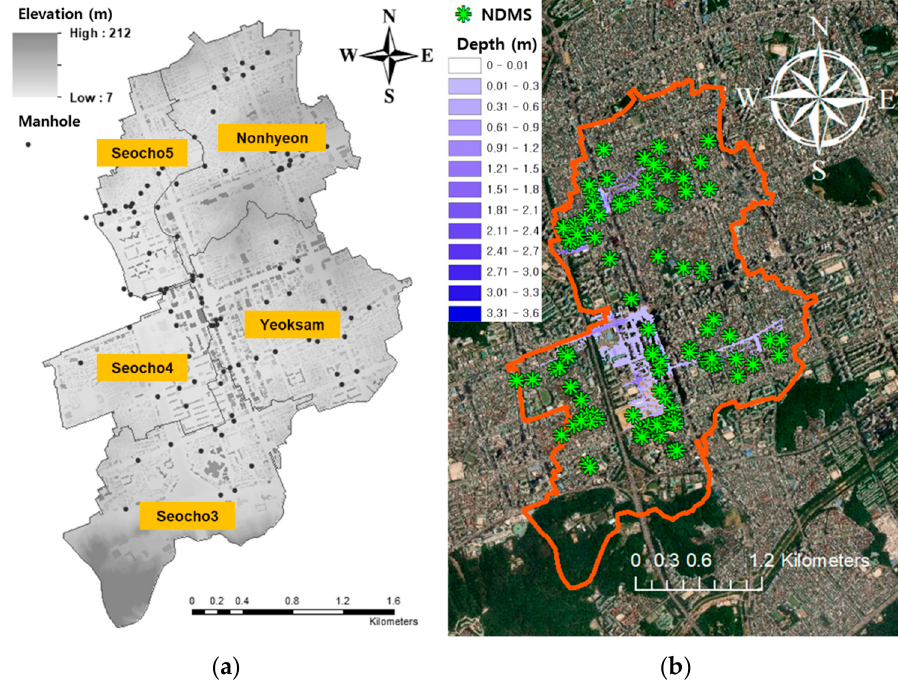
Figure 2. Study area and validation. ( a ) Flooded Manhole; ( b ) Flood Simulation and National Disaster Management System (NDMS).